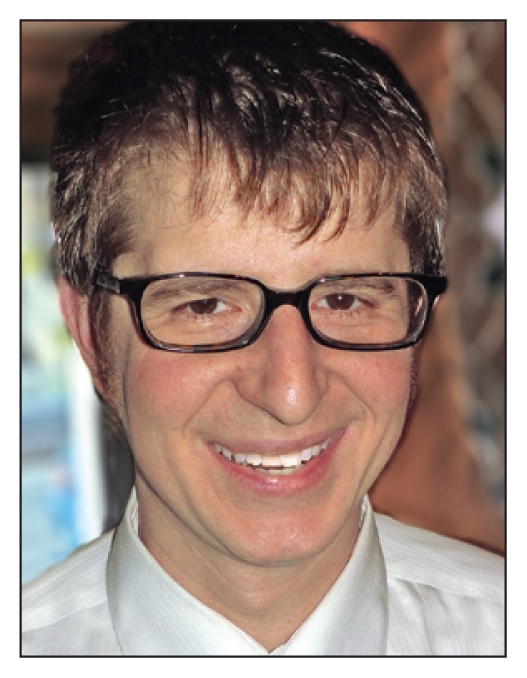
Leonardo Trasande